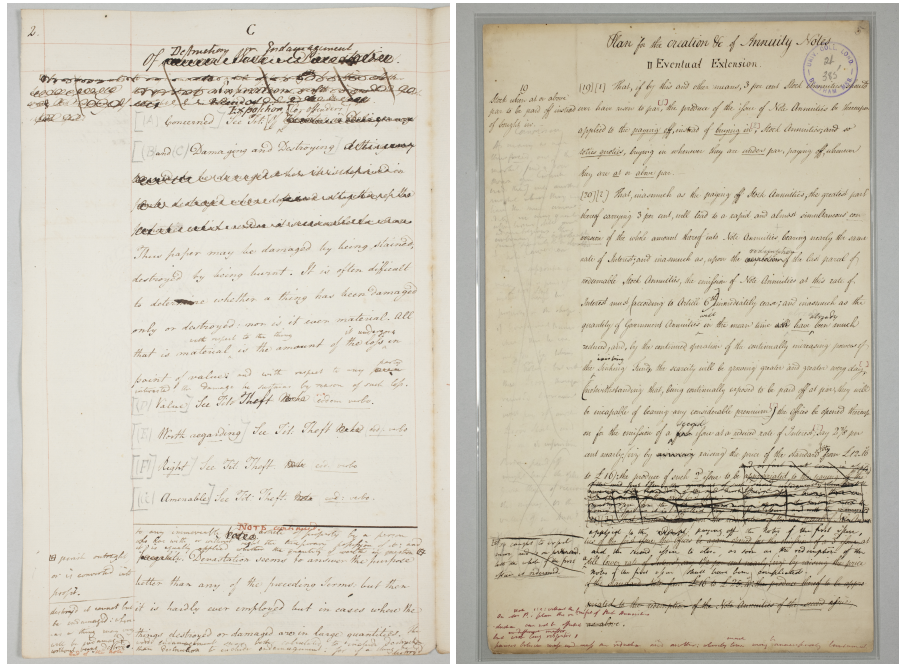
Figure 9. Example pages from the ICDAR2015-HTR